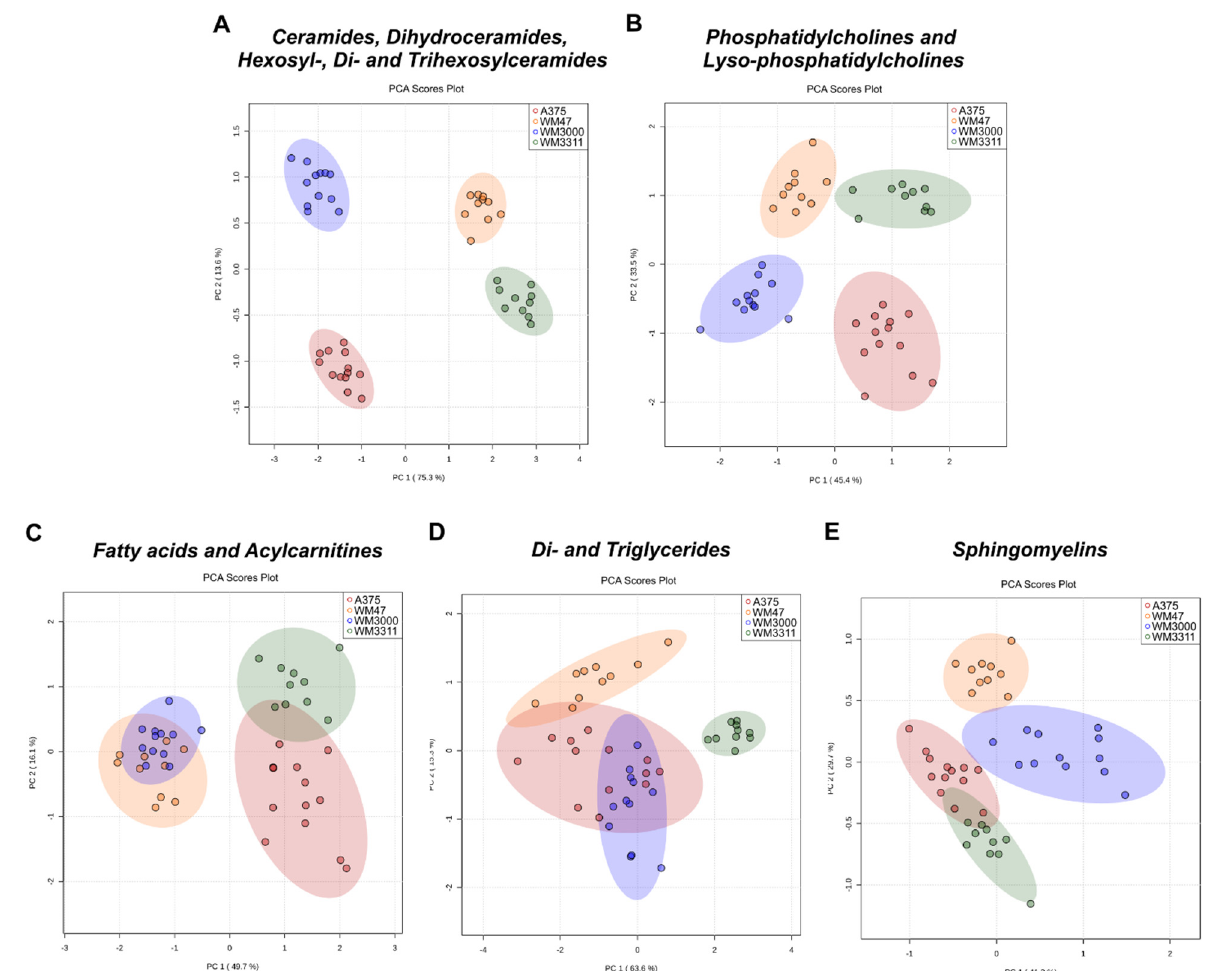
Figure 4. Metabolic analysis of lipid-subclasses in melanoma xenografts. PCA scores derived from lipid and lipid-like metabolite profiling data of A375, WM47, WM3000, and WM3311 melanoma xenografts divided into lipid-subclasses: ( A ) ceramides, dihydroceramides, hexosylceramides, di- and trihexosylceramides, ( B ) phosphatidylcholines and lyso- phosphatidylcholines, ( C ) fatty acids and acylcarnitines, ( D ) di- and triglycerides, and ( E ) sphingomyelins; n = 10–13.